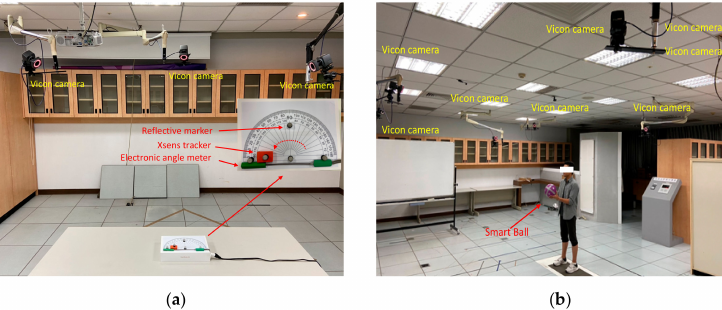
Figure 9. Illustrations of the validation tests: ( a ) for the Xsens tracker and ( b ) for the smart ball. All of the tests were captured under eight surrounded Vicon